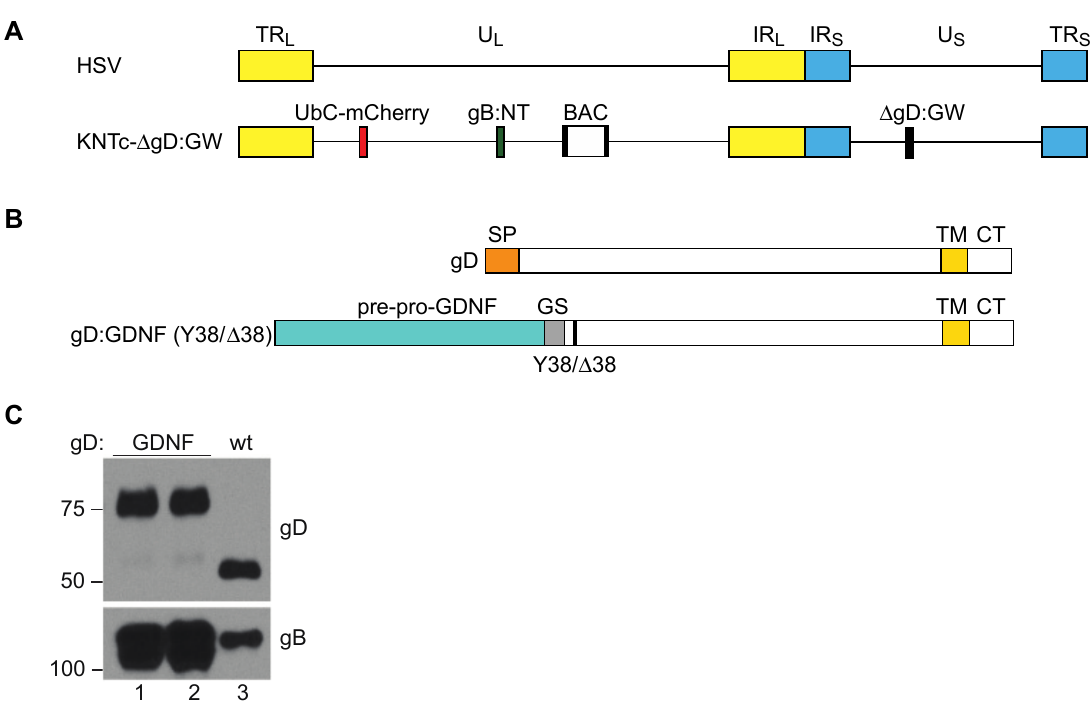
Figure 1. Vector engineering. ( A ) Schematic depiction of the herpes simplex virus (HSV) genome. Terminal repeats (TR L , TR S ) of the unique long (U L ) and unique short (U S ) segment, respectively; inverted internal repeats (IR L , IR S ) of the unique long (U L ) and unique short (U S ) segment, respectively. The KNTc- ∆ gD:GW genome represented underneath contains loxP-flanked bacterial artificial chromosome (BAC) sequences, a ubiquitin C (UbC)-promoter driven mCherry cassette (UbC-mCherry), a GW cassette in place of the glycoprotein D (gD) coding sequence ( ∆ gD:GW), and mutations in glycoprotein B that enhance retargeted virus entry (gB:NT) [36]. ( B ) Illustration of wild type gD, depicting the approximate size and location of the signal peptide (SP), transmembrane domain (TM), and cytoplasmic tail (CT), and the recombinant gD proteins gD:GDNF and gD:GDNF ∆ 38; Y38 / ∆ 38 refers to the wild type (wt) gD residue 38 (Y) or the deleted ( ∆ ) residue 38. In both recombinant proteins the pre-pro-GDNF ligand was tethered to the C-terminus of gD at amino acid 25 by a flexible glycine-serine spacer (GS; (G 4 S) × 3). ( C ) Western blot analysis of gD:wt and gD:GDNF proteins incorporated into purified virus particles. 1 × 10 8 genome copies (gc) of purified virus particles were loaded per lane and blotted with either anti-gD or anti-gB antibodies. Lanes 1 and 2 represent virus stocks from two independent KNTc-gD:GDNF BAC isolates. The virus stock from lane 1 was used for the experiments pictured in Figure 2; the two isolates yielded comparable results.